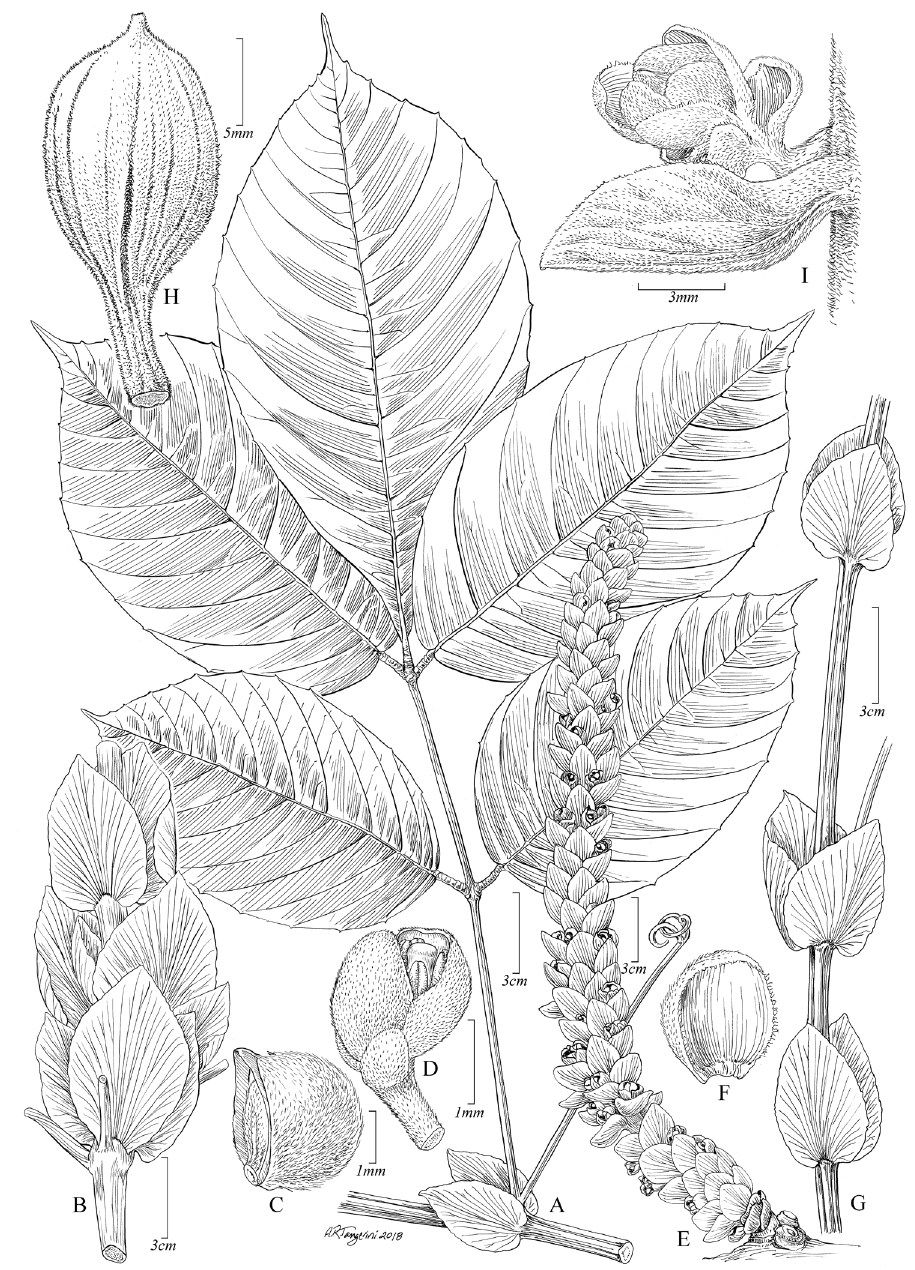
Figure 5. Paullinia martinellii . A Branch fragment with leaf, stipules and tendrils B Branch with cata- phylls C Flower bud covered by bracts and bracteoles D Immature flower E Inflorescence F Posterior sepal, frontal view G Branch showing stipules H Immature fruit I Immature cincinnus with overlapping bracts and bracteoles. A–D, F, H from Davidson & Martinelli 10661 (US) E, G from Martinelli & Davidson 7158 (RB) I from Cid et al. 1223